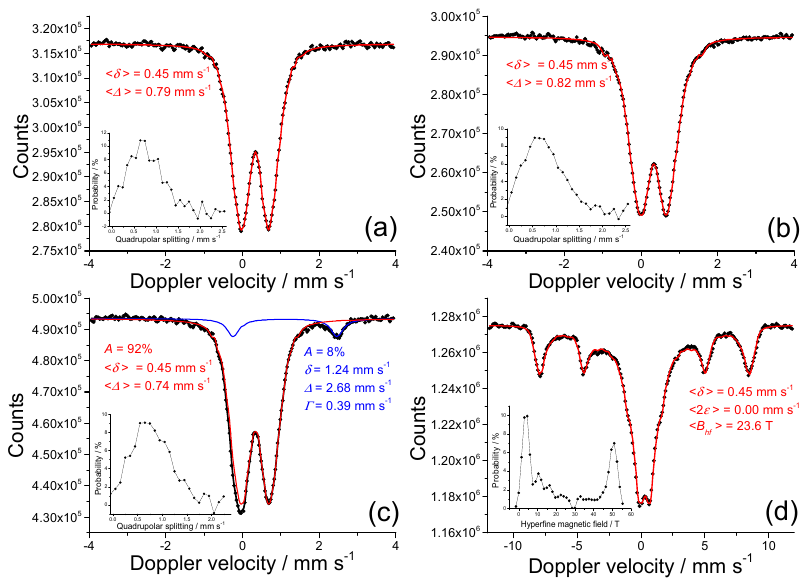
Figure 5. The 77 K Mössbauer spectra of PEO/Fe-oxide gels obtained from suspensions with: 5 wt% Fe 3+ at 130 kGy ( a ); 20 wt% Fe 3+ at 130 kGy ( b ); 5 wt% Fe 3+ at 300 kGy ( c ); 20 wt% Fe 3+ at 300 kGy ( d ). All precursor suspensions were prepared from 1.85 wt% PEO solutions and with 0.2 M 2-propanol. Mössbauer parameters are given: δ = isomer shift relative to α -Fe at 20 °C; Δ = quadrupole splitting; Γ = line width; B hf = hyperfine field, A = relative area. Δ values are given as an average value of quadrupole splitting distributions ( a – c ). B hf value is given as an average value of hyperfine field distribution ( d ). Line width values were fixed during the fitting of quadrupole splitting distribution ( a – c ) or hyperfine field distribution ( d ). Error: δ = ± 0.01 mm s − 1 ; Δ = ± 0.01 mm s − 1 ; B hf = ± 0.3 T.